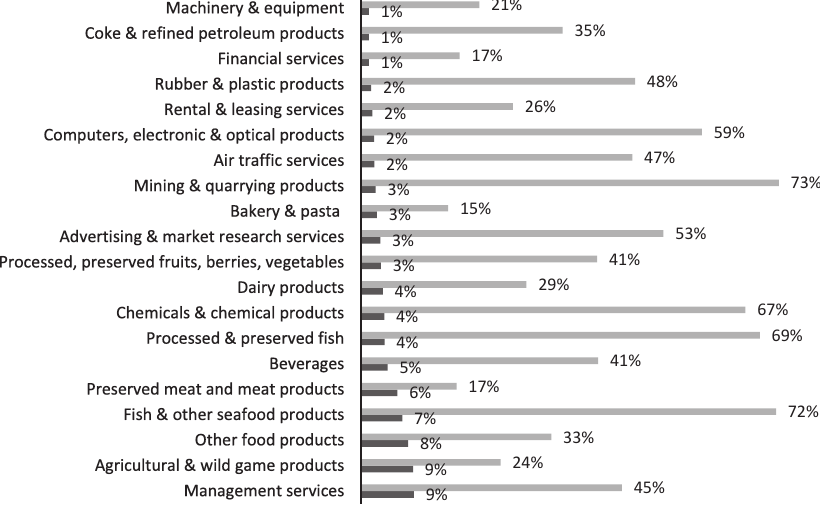
Fig. 7. Restaurants and food services dependency on imports for the total supply of direct and indirect inputs into the